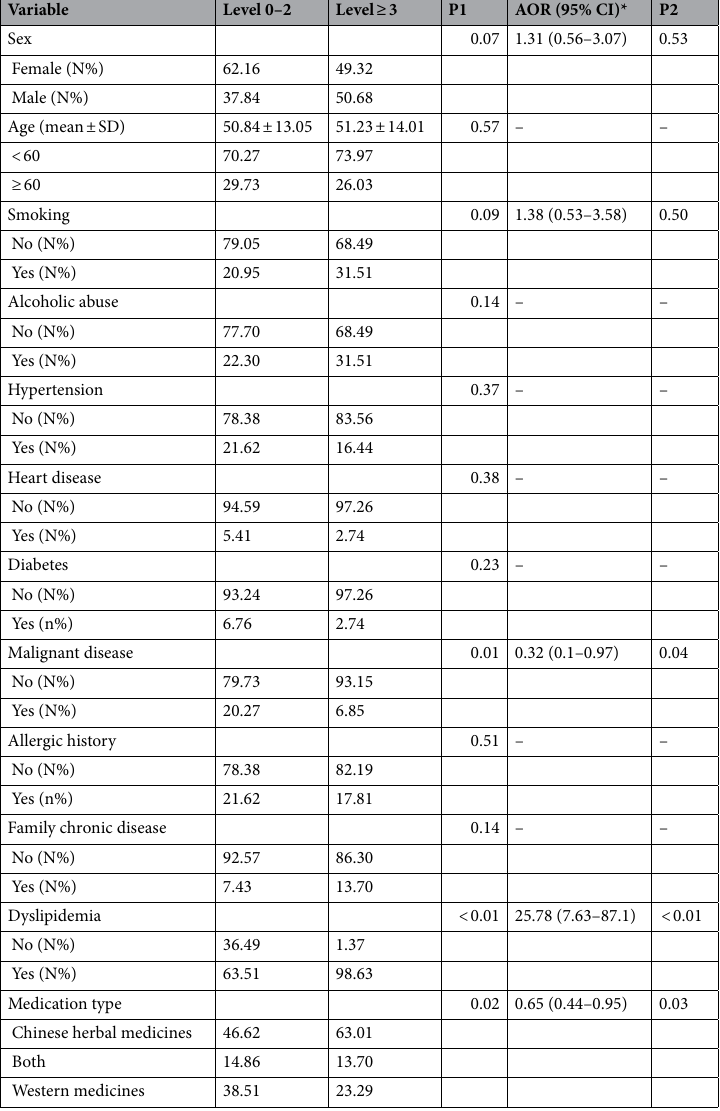
Table 2. Univariate analysis and multivariate analysis of patients’ characters in mild and severe DILI group. DILI drug induced liver injury, AOR : adjusted odds ratio. P1 P value for univariate analysis, P2 P value for multivariate analysis. *Adjusted for sex, smoking, malignant disease, dyslipidemia and medication